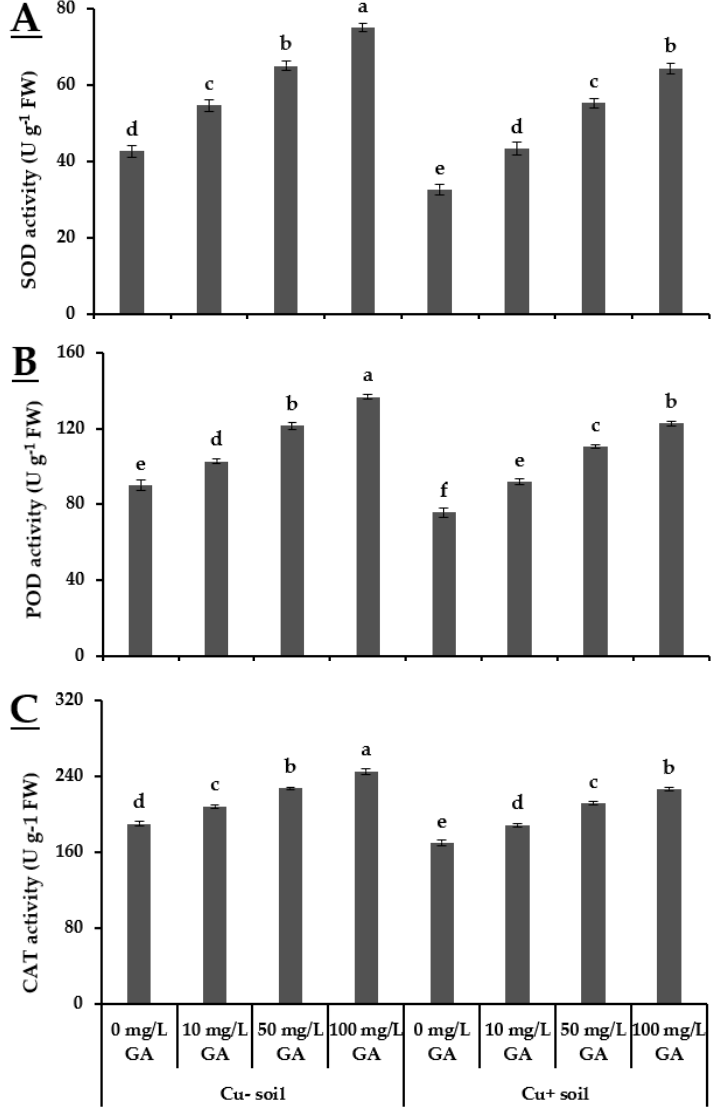
Figure 3. Effect of GA 3 on activity of reactive oxygen species (superoxide dismutase (SOD), peroxidase (POD), catalase (CAT)) of peas grown in Cu+ and Cu− soils. ( A ): SOD activity; ( B ): POD activity; ( C ): CAT activity. Different letters indicate significant difference among treatment means according to Tukey’s honestly significant difference (HSD) test ( p ≤ 0.05). Vertical bars indicate mean ± standard error ( n = 4, 5 plants per replicate under bi-factorial CRD arrangement).